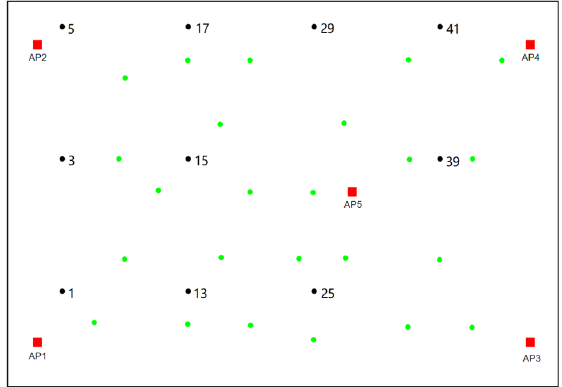
Figure 6. Distribution of the coarse acquisition for Wi-Fi fi ngerprints, with the red “ □ ” representing the five APs; the black dots with the labeled number for the coarse site-surveying grids; the green dots for the test-points.